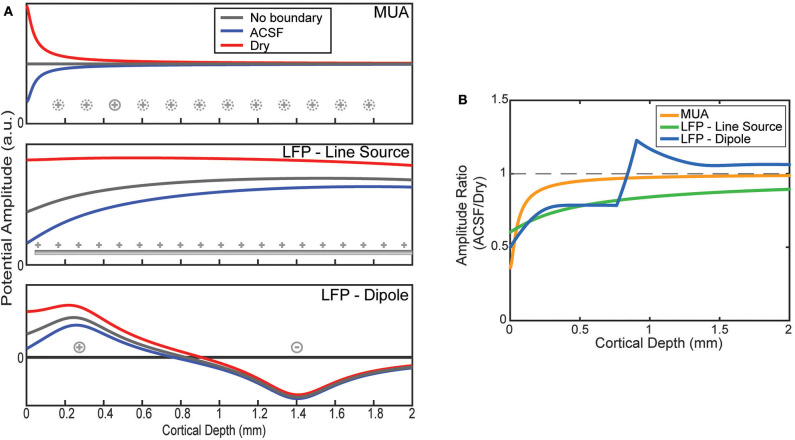
Model predictions of boundary on laminar electrode recordings. (A) Potentials as a function of depth are modeled by assuming a source configuration (as shown in Figure 1C). Depth profiles are plotted for an infinite medium and one bounded by ACSF or an insulator. (B) The ratios between the ACSF and insulating (dry) condition predicted by the model as a function of electrode depth.